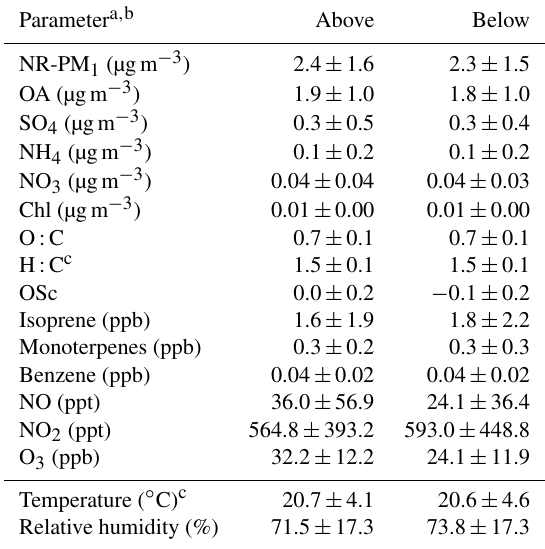
Table 2. Campaign-averaged values ( ± 1 standard deviation) of mass concentrations of NR-PM 1 , VOC, and trace gas mixing ratios and meteorological parameters above and below the canopy.